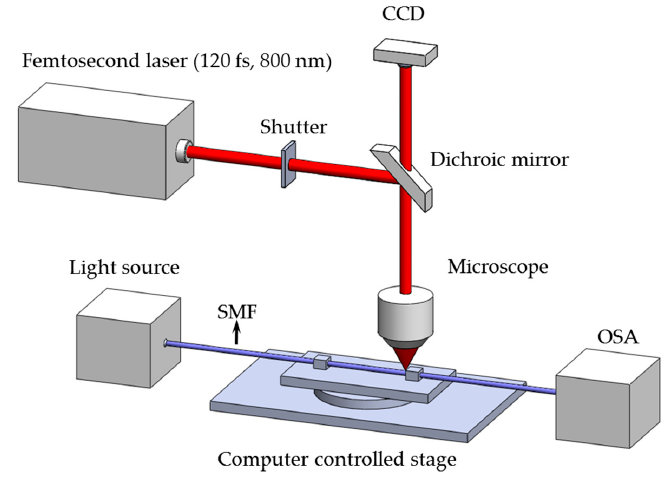
Figure 9. Schematic illustration of the experimental setup.